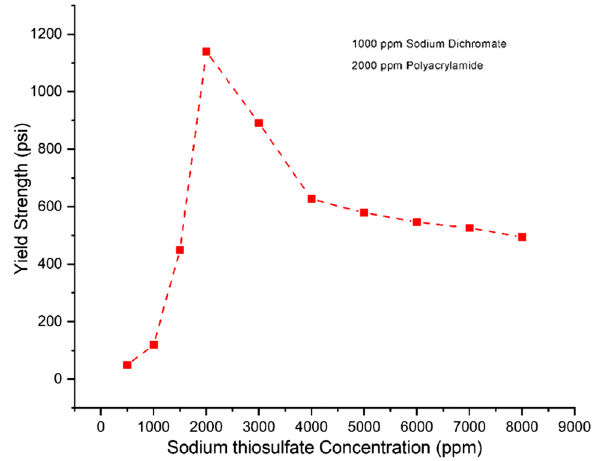
Fig. 3 Viscosity behavior of crosslink system vs. time under ambient conditions (24 °C and 14.7 psia)